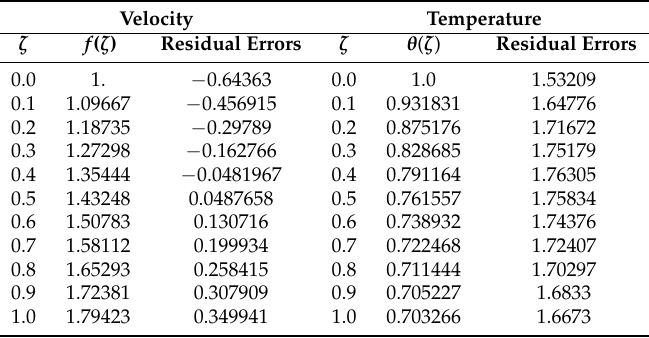
Table 4. Results achieved by HAM and Residual